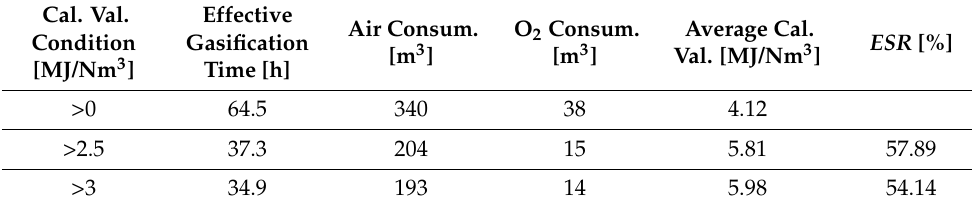
Table 5. The efficiency of the UCG process for the second experiment. Cal.